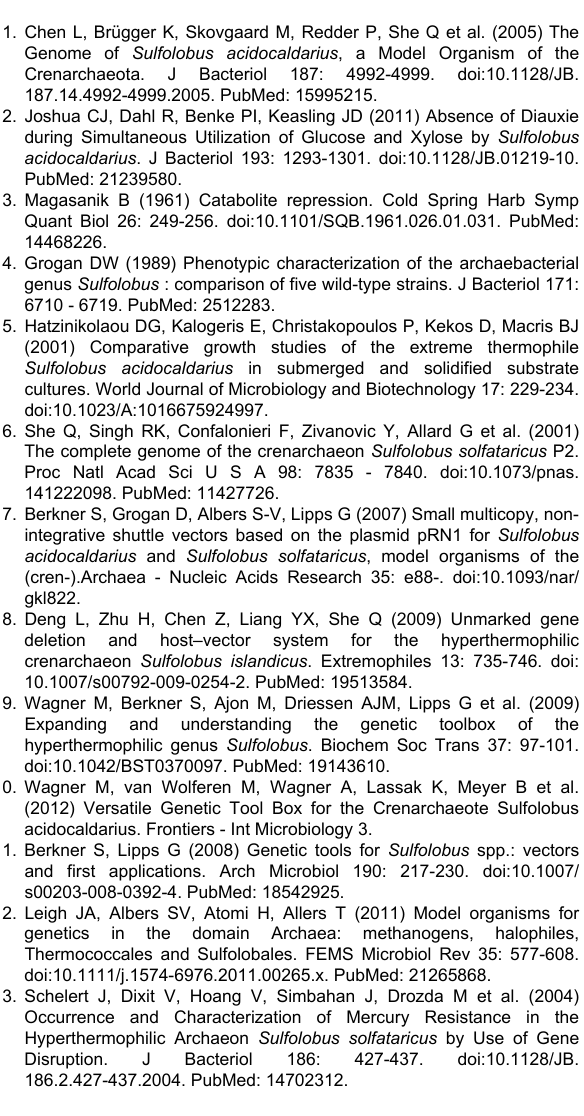
Figure S6. Secondary structure of the putative origin of replication at 37°C. The mFold structure highlights potential hairpin structures at the 5’- and 3’-ends of the putative origin. The regions deleted in pRSP1a – pRSP1d are highlighted (arrows).